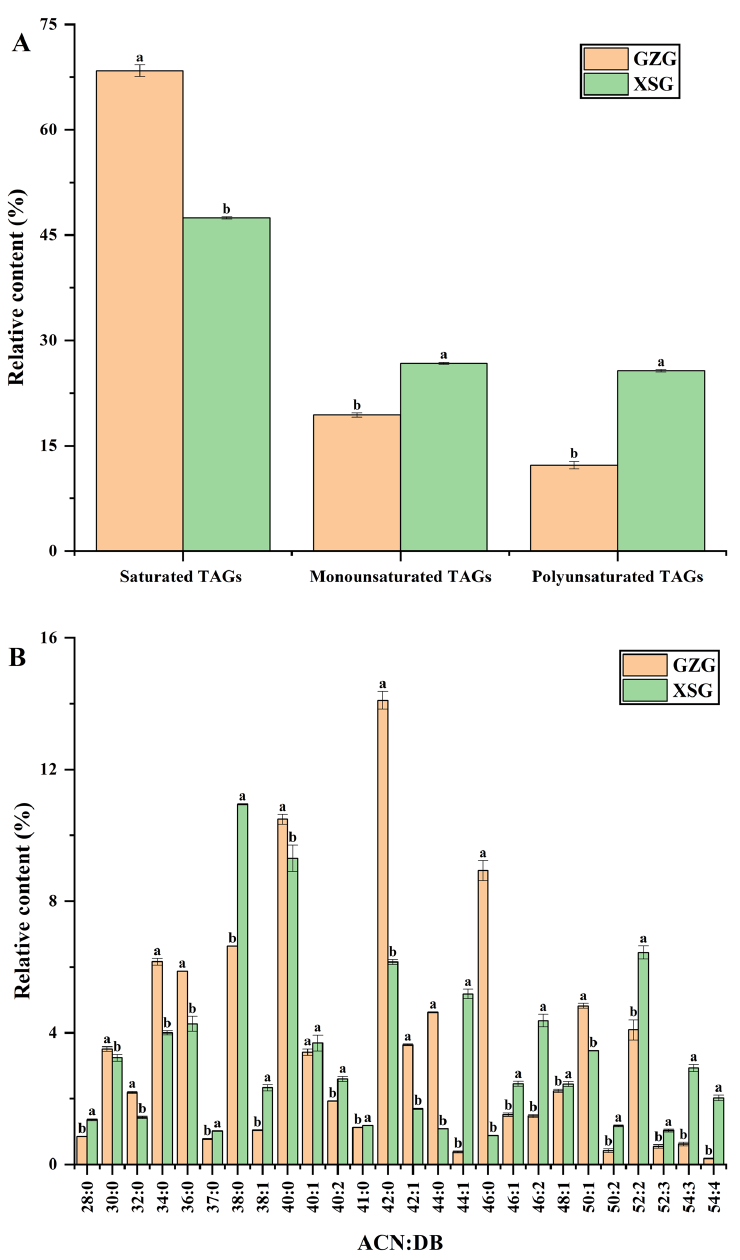
Figure 3. ( A ) Saturation distribution of TAGs; ( B ) Molecular weight distribution of TAGs (>1% of total TAGs) presented as ACN:DB (acyl carbon number:number of double bonds). GZG, Guanzhong goat milk; XSG, Xinong Saanen goat milk. Results represent mean ± standard deviation (indicated by vertical error bars), n = 3. Columns bearing different letters indicate statistical difference ( p ≤ 0.05) between the two goat dairy breeds by independent samples t -test.